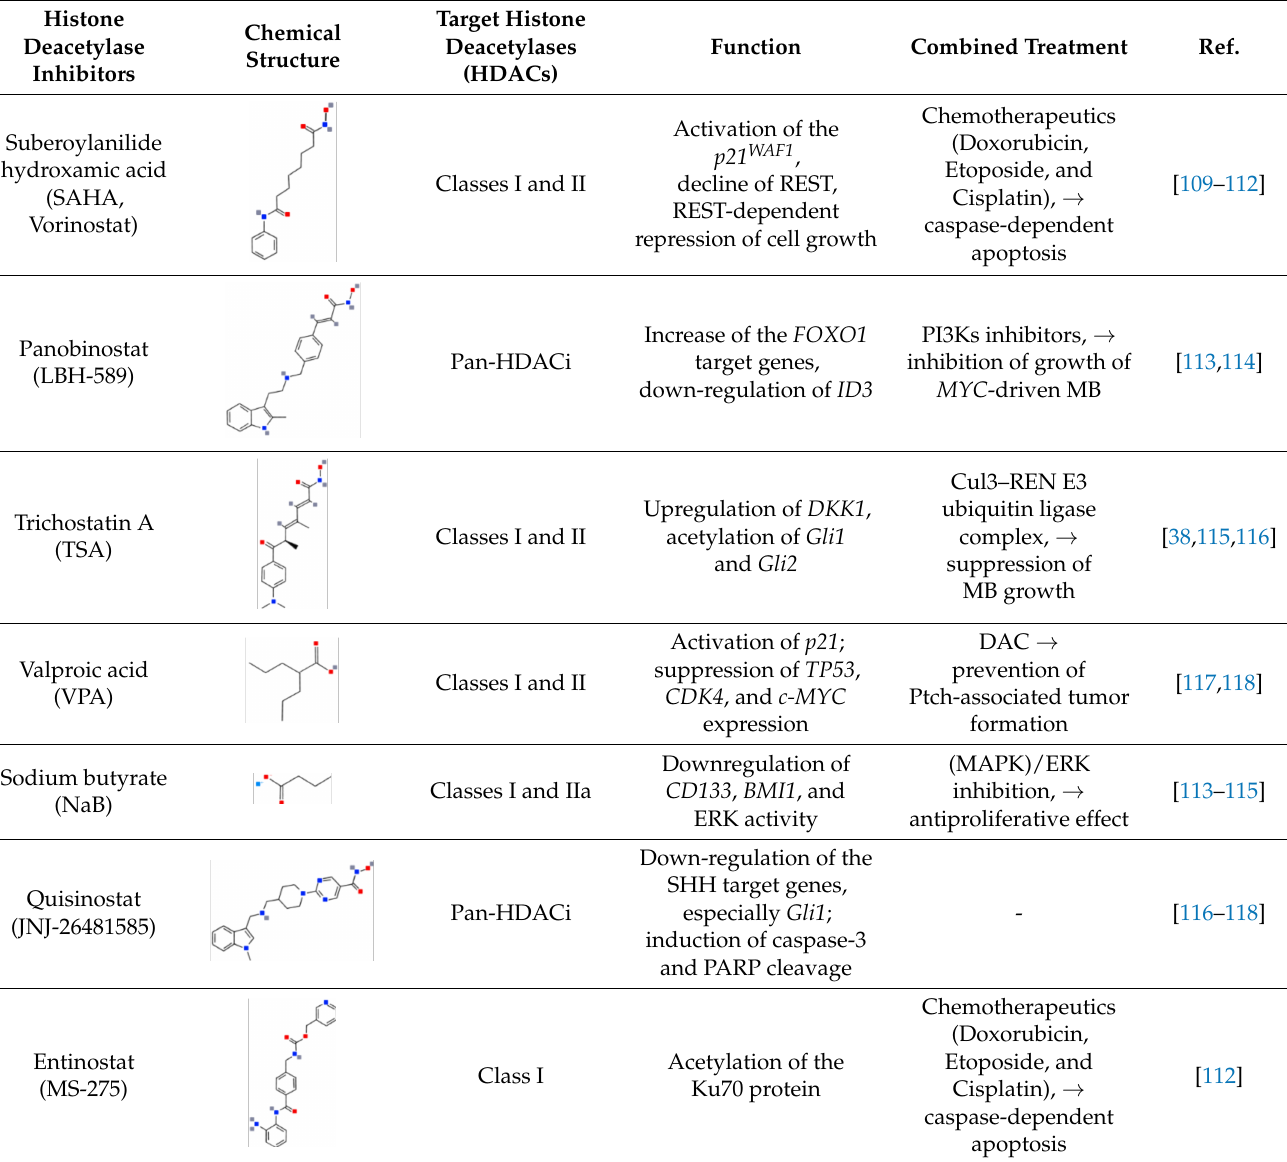
Table 5. Selection of the most researched histone deacetylase inhibitors in